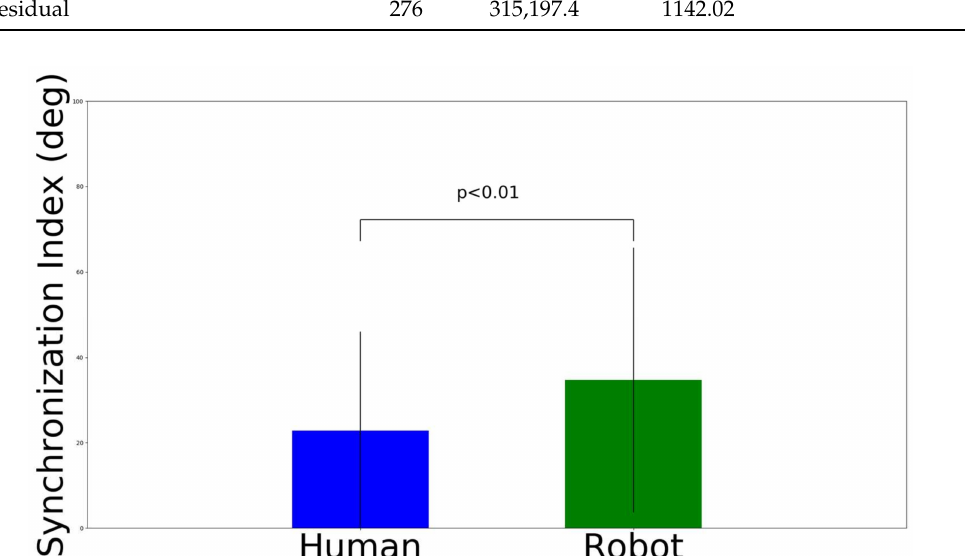
Figure 13. Synchronization index results on orthogonal horizontal movement